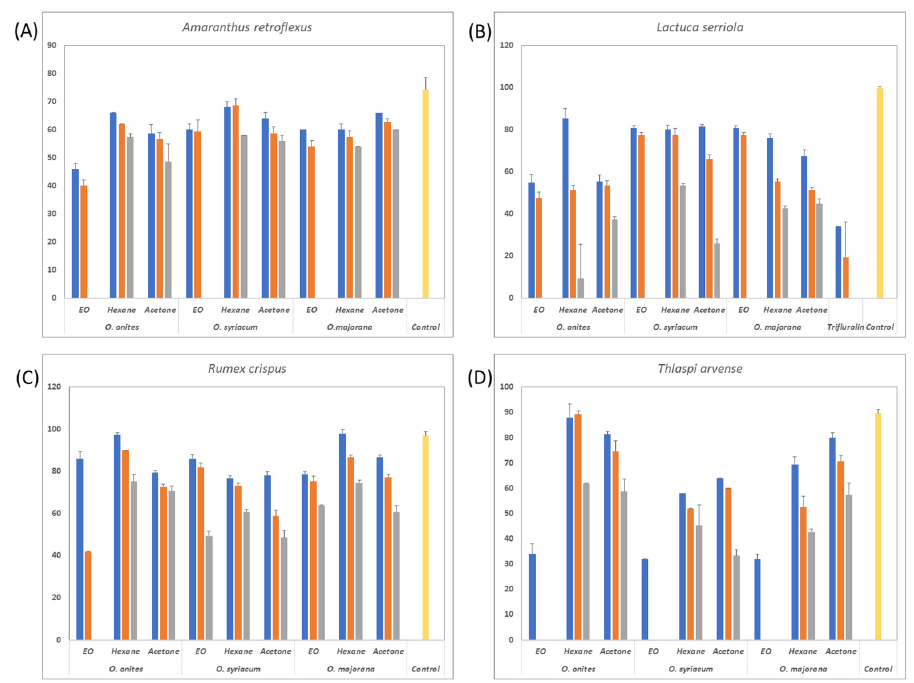
Figure 1. The seed germination rates (%) of ( A ) Amaranthus retroflexus , ( B ) Lactuca serriola , ( C ) Rumex crispus , ( D ) Thlaspi arvense . Blue bars indicate 5 µL dose application while red bars 10 µL, grey bars 20 µL. The yellow bars indicate control application.